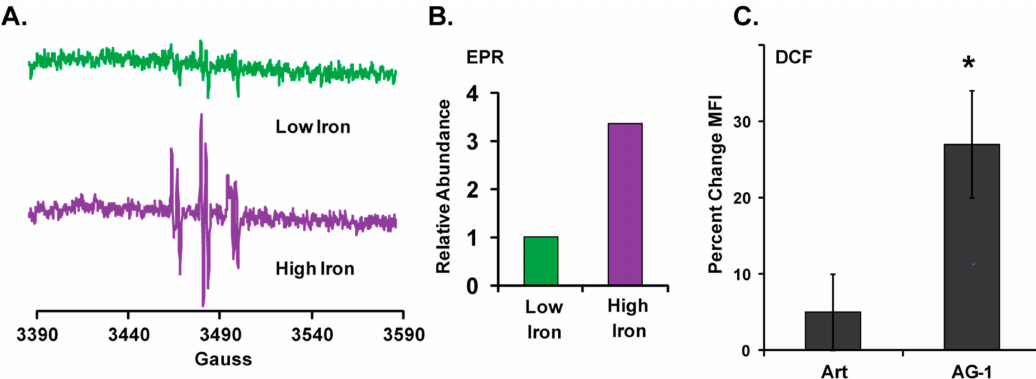
Figure 7. Artemisinin dimer (AG-1) generates carbon-centered radicals in cell-free system, and it increases the steady-state levels of cellular reactive oxygen species (ROS). ( A ) Detection of AG-1 derived carbon-centered radicals in cell-free system. AG-1 (1 mM) was incubated in phosphate bu ff er saline (pH 7.4) containing 25 mM POBN ( α -(4-pyridyl-1-oxide)- N - tert -butylnitrone) in the presence of 20 µ M or 100 µ M ferrous sulfate. EPR (Electron Paramagnetic Resonance) spectra have the characteristics of spin adducts of two di ff erent carbon-centered radicals (radical-1, a N = 16.0 G, a H = 2.8 G; radical-2, a N = 14.7 G, a H = 2.4 G with a g-shift of about 0.25 G and a concentration ratio close to 1:1). Representative spectra showing AG-1 derived carbon-centered radicals are shown. ( B ) Bar graph represents relative abundance of carbon-centered radicals in the presence of low (20 µ M) and high (100 µ M) concentrations of ferrous sulfate. ( C ) AG-1 treatment increases the intracellular flux of oxidants. MB-231 cells were treated with 50 µ M of Art or AG-1 for 15 minutes and then incubated with H 2 DCF-DA (5-(and-6)-carboxy-2 (cid:48) ,7 (cid:48) -dichlorodihydrofluorescein diacetate). H 2 DCF-oxidation, i.e., formation of DCF, was measured by flow cytometry and percent change in MFI (Mean Fluorescence Intensity) was calculated relative to untreated controls for individual treatments. Results are presented as average and standard deviation. Asterisks represent significance compared to Art-treated cells; n = 3, p <